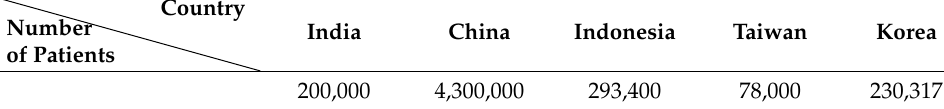
Figure 15. Vague graph ζ of transferability cancer patients. Table 2. The number of cancer patients.